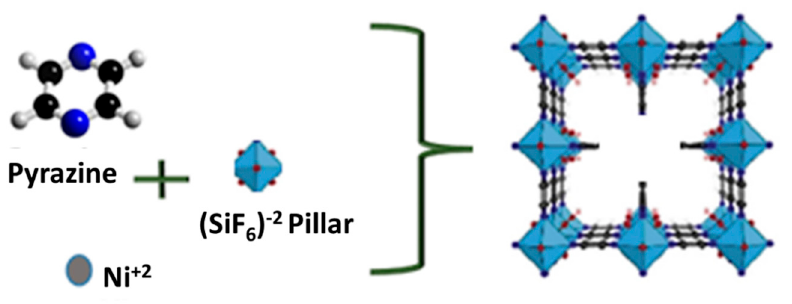
Figure 1. Illustrative structure of SIFSIX-3-Ni.